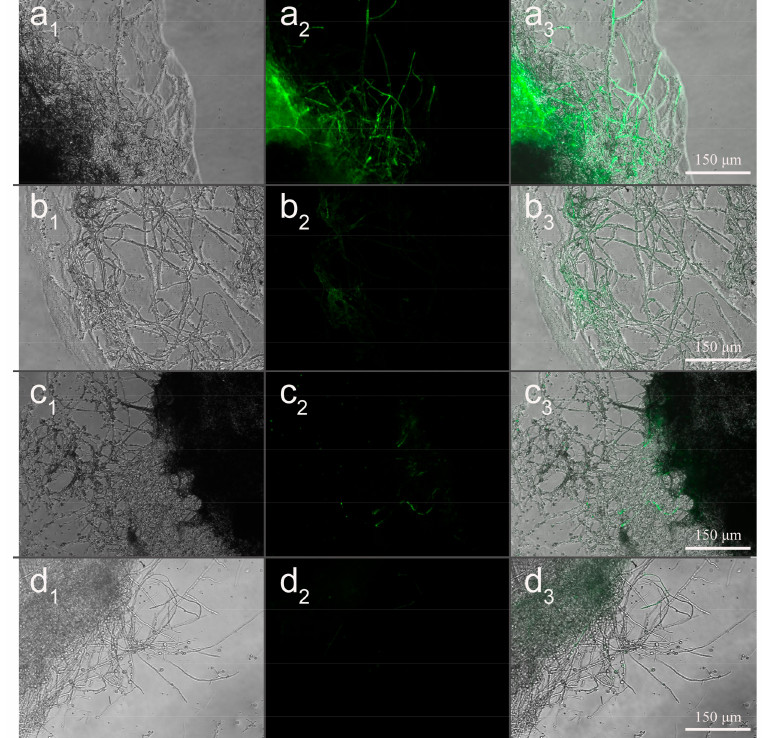
Figure 14. Fluorescence microscopy images of Colletotrichum higginsianum Sacc after treatment with the azoxystrobin microspheres. ( a ) MS1; ( b ) MS2; ( c ) MS3; ( d ) CK. Note: 1, bright field; 2, dark field; 3,